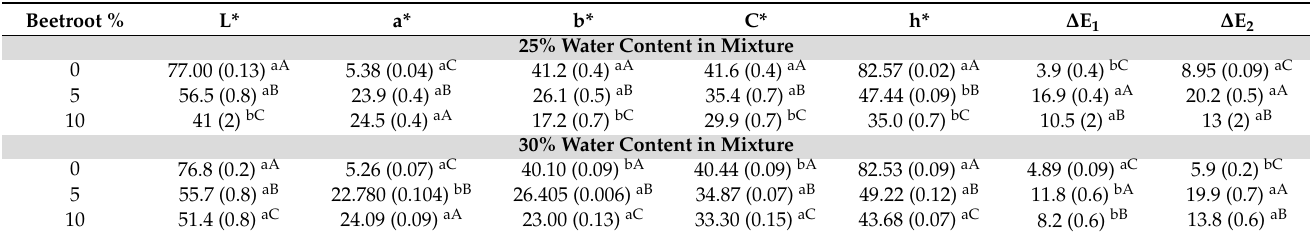
Table 4. Mean values (and standard deviations) of color coordinates (L*, a*, b*, C*, and h*) and total color differences ( ∆ E 1 and ∆ E 2 ) of the finished expanded product. ∆ E 1 : total color difference between the mixture before extrusion and the finished expanded product. ∆ E 2 : total color differences between the dry pellet and the finished expanded product.